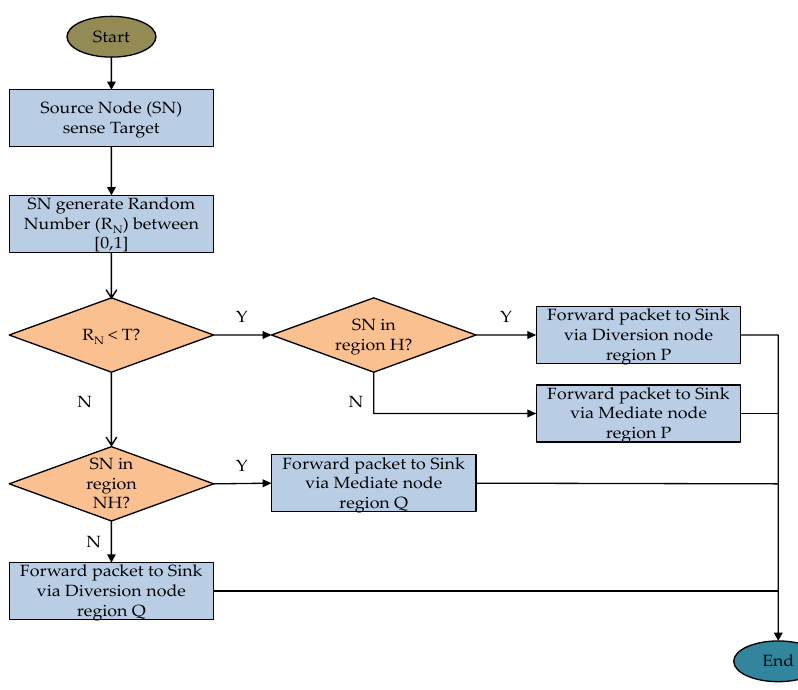
Figure 6. The flowchart of delivering a packet from the source node to the sink node.